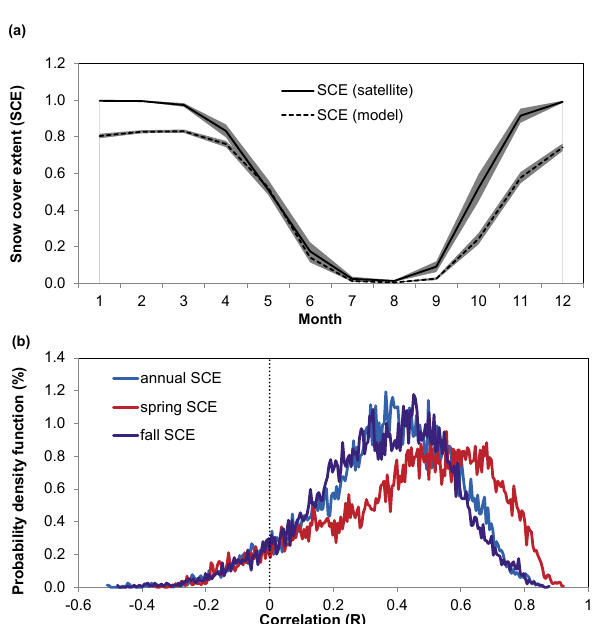
Figure 3. Comparisons of model simulations and satellite-based climate data records (CDR) of snow cover extent (SCE; Brown and Robinson 2011) over the pan-Arctic modeling domain. Panel (a) : the seasonal cycle of modeled and satellite-observed SCE; panel (b) : the probability density function of the correlation coef- ficient ( R ) between modeled and satellite-observed SCE on annual and seasonal timescales (spring: March to May; fall: September to November) from 1982 to 2010. Gray shading in (a) denotes the tem- poral standard deviation from the multiyear means for the 1982 to 2010 record.